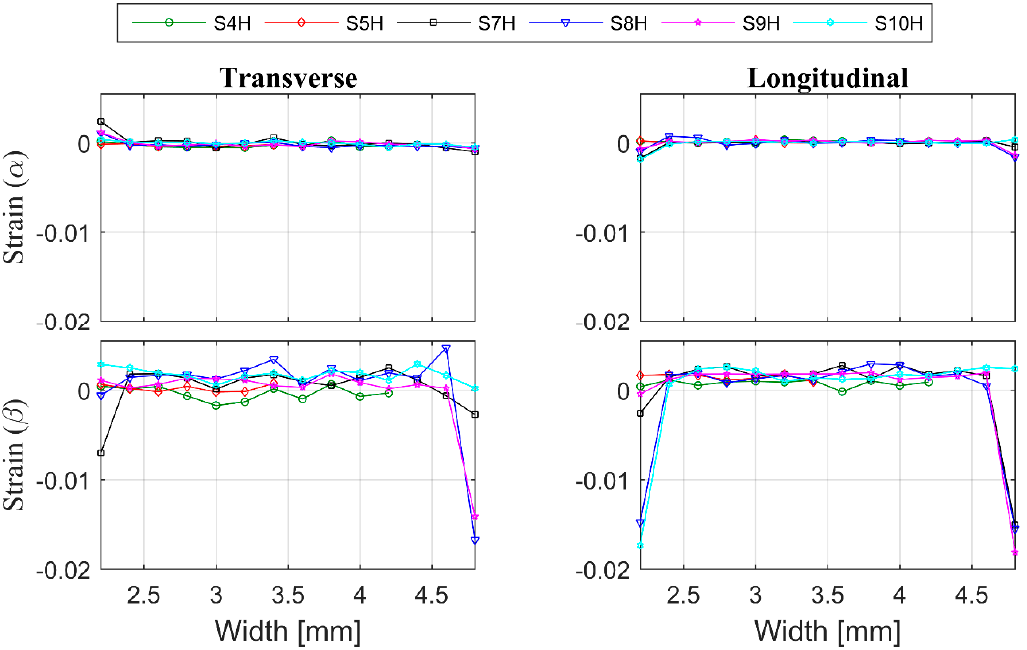
Figure 11. The lattice strain from the central horizontal line of a specimen that is parallel to the EBM build plane. Transverse direction at left, and longitudinal direction at right.